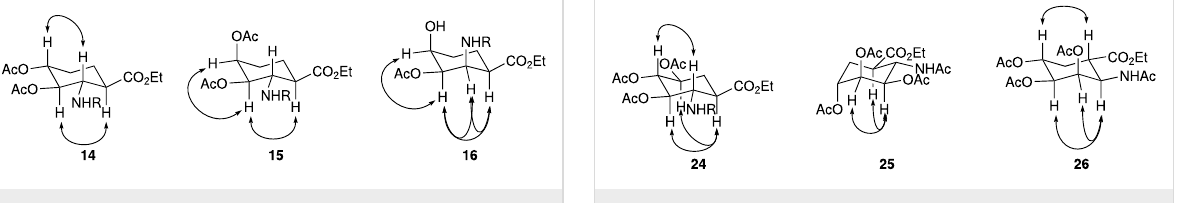
Figure 2: Selected NOESY Correlations for 14 – 16 (R = Boc)